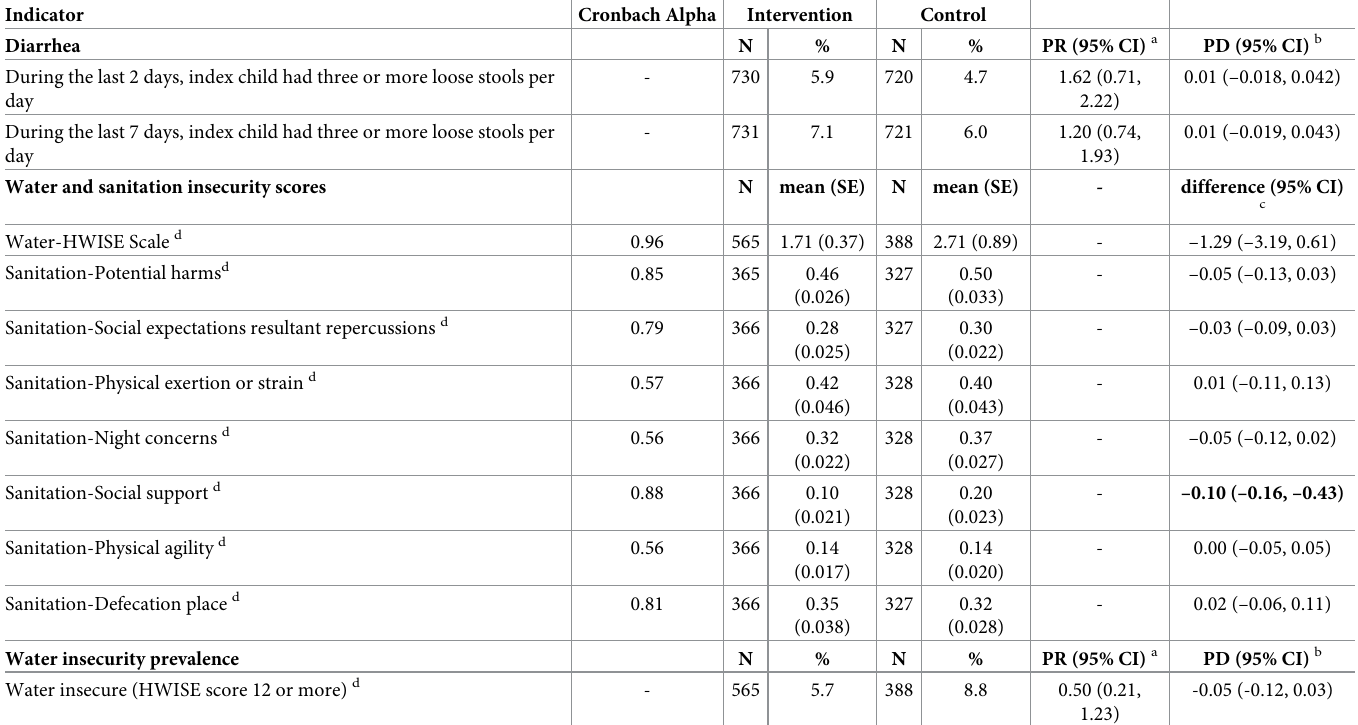
Table 3. Secondary health outcomes at